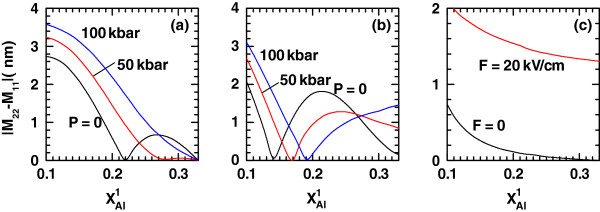
The same as Figure4but for the absolute difference of dipole matrix elements|M22−M11|.